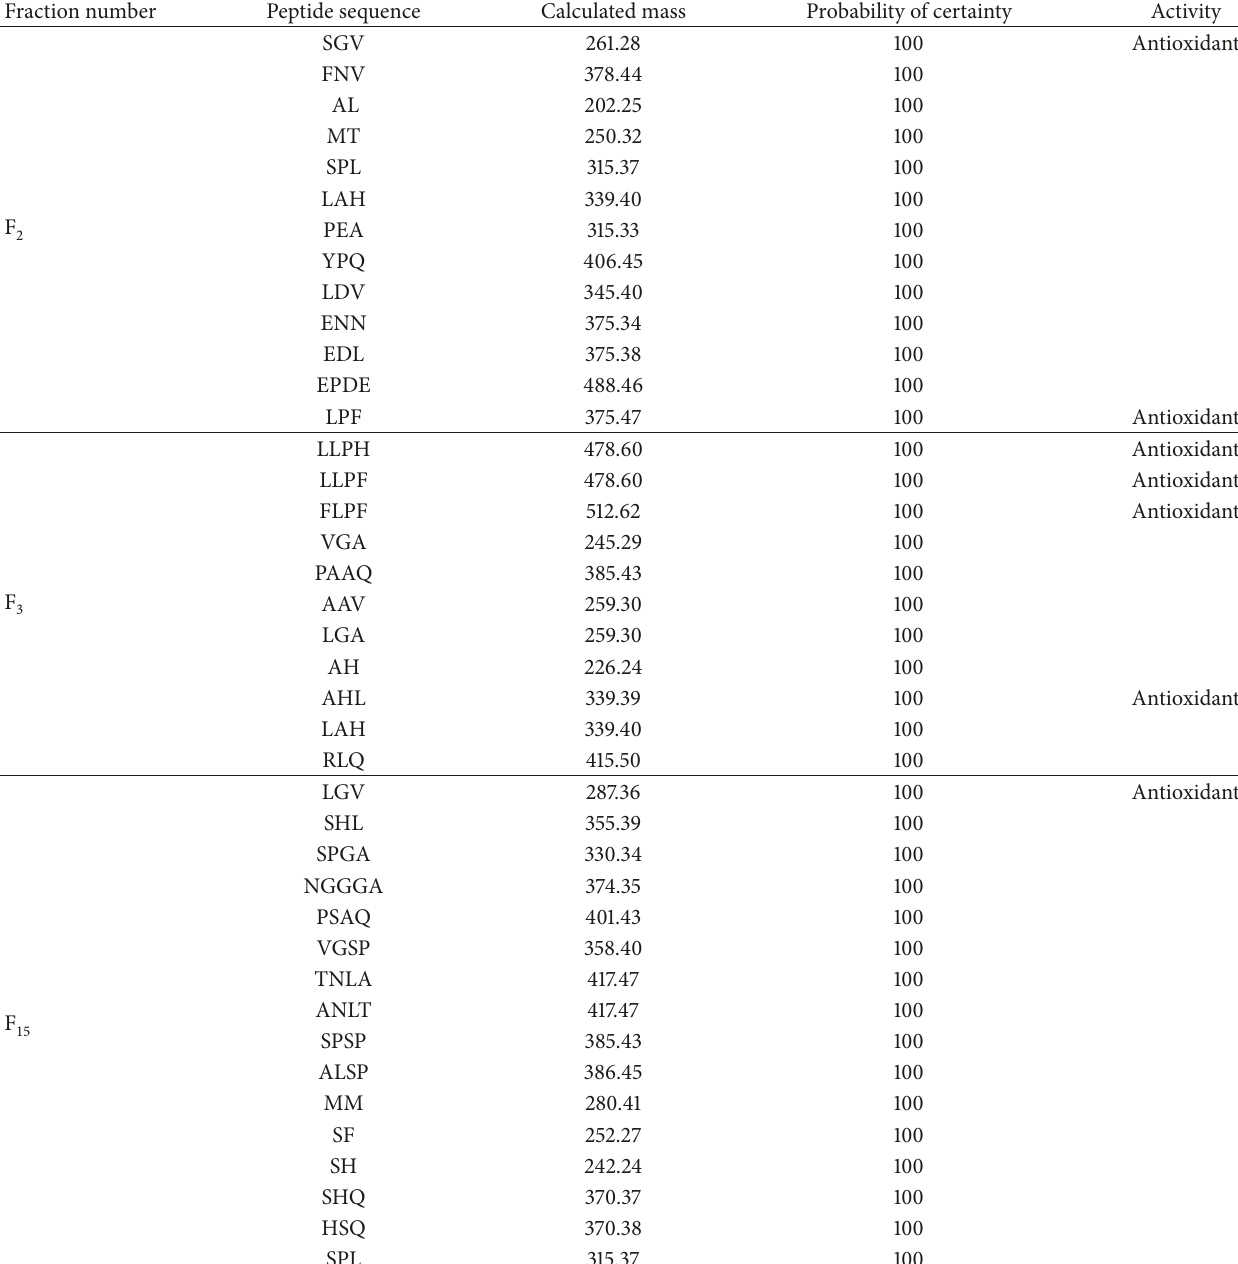
Table 5: Amino acid sequence of purified peptide (F 2 , F 3 , and F 15 ) identified using